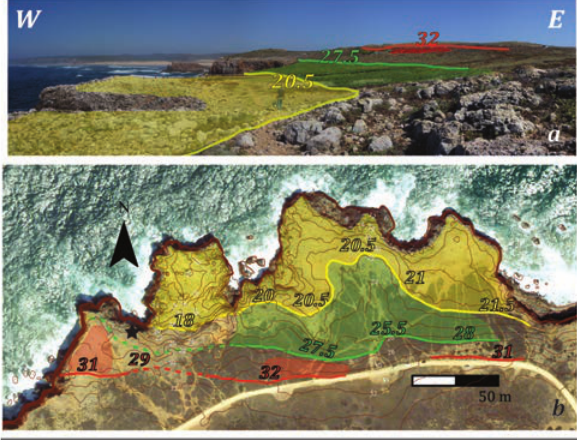
Figure 8. Panoramic view of Carrapateira, northern section Carra- pateira site, showing the northern section of the promontory. Ma- rine terrace mapping: a) panoramic view and terrace perspective (site where picture was taken marked by “star” at b); b) inner edge and terrace map. For each terrace, the inner edge is mapped, solid line when visible, dashed line when inferred; Yellow-T2; Green-T3; Red-T4. Inner edge elevations are provided in meters. T3 and T4 are not discussed in detail in this